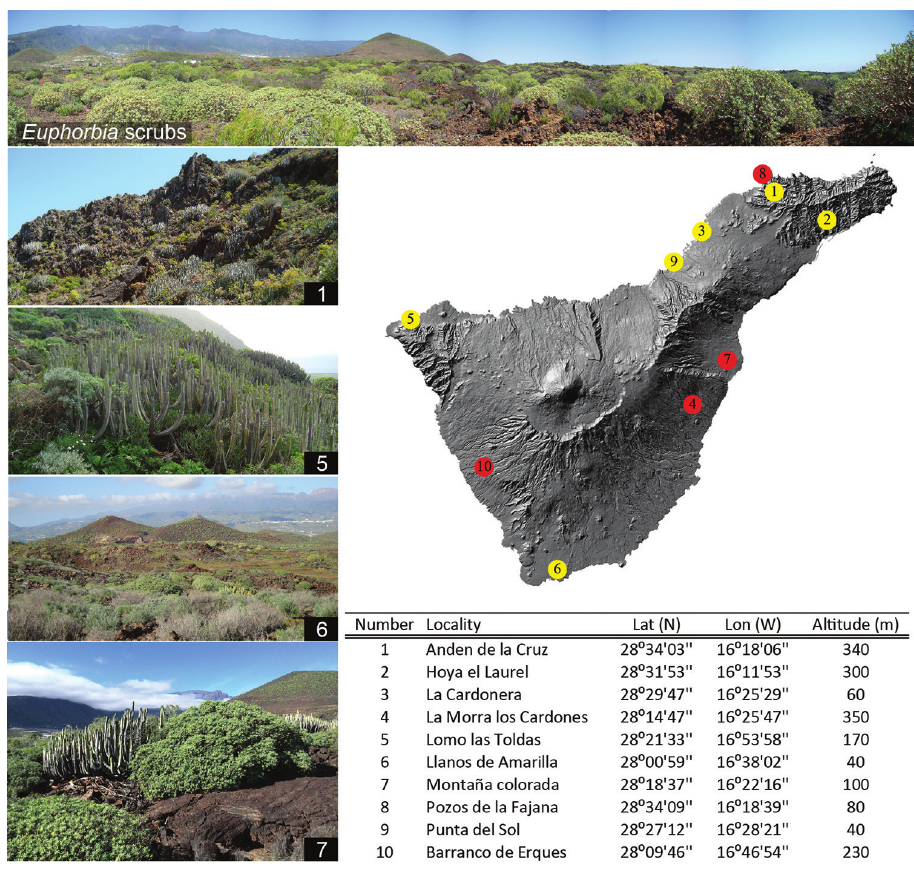
Figure 1. Monitored localities in Euphorbia scrubs: number of locality, place name for locality according to IDECanarias visor 3.0 (http://visor.grafcan.es/visorweb/), latitude, longitude, and altitude. In yellow the localities where Orbilia beltraniae was